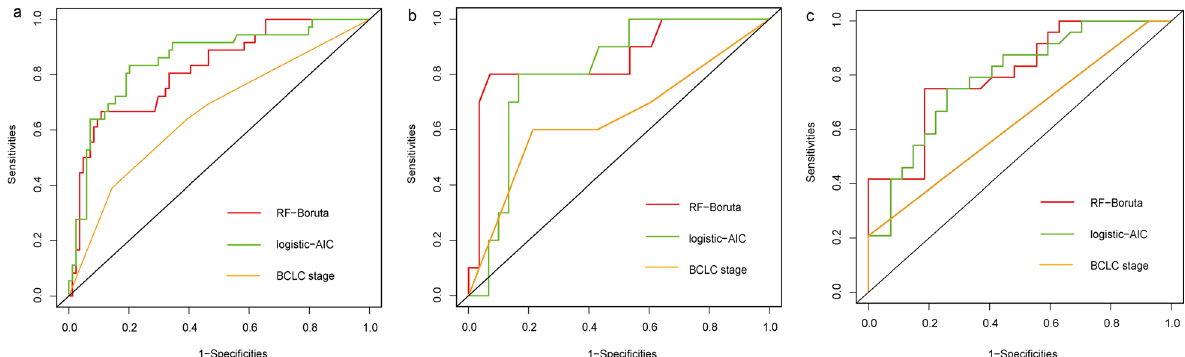
Fig. 3 Receiver operating characteristic analysis for the prediction models. a Training Set; b Internal validation set; c External validation set. RF-Boruta, Random Forest model with Boruta algorithm; Logistic-AIC, Logistic regression model with stepwise selection (Akaike information criterion); BCLC, Barcelona Clinic Liver Cancer